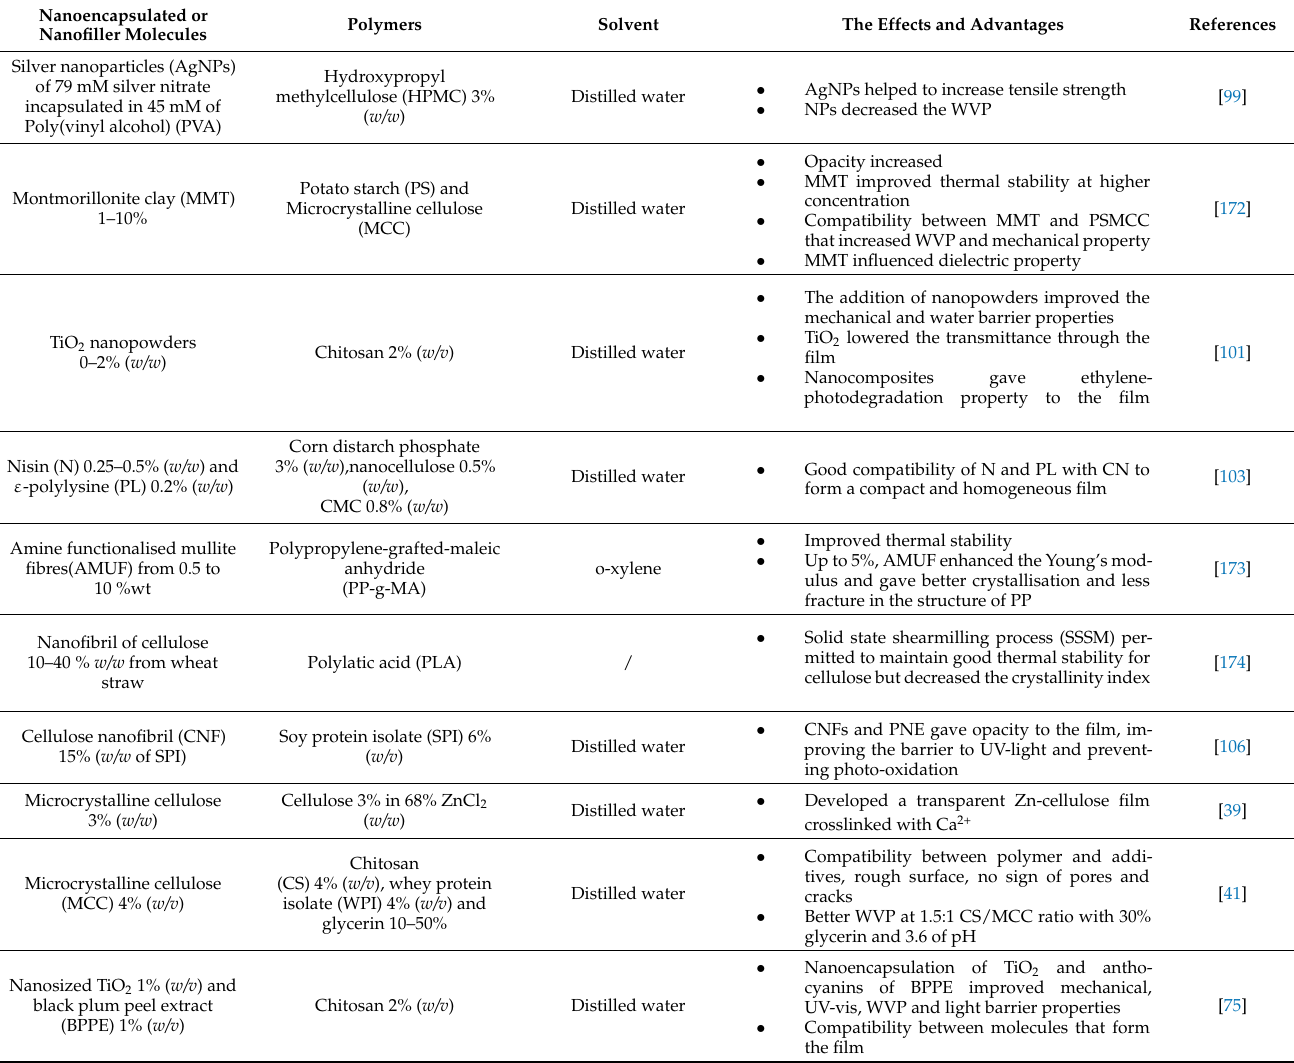
Table 5. Application of nanoparticle technologies to food